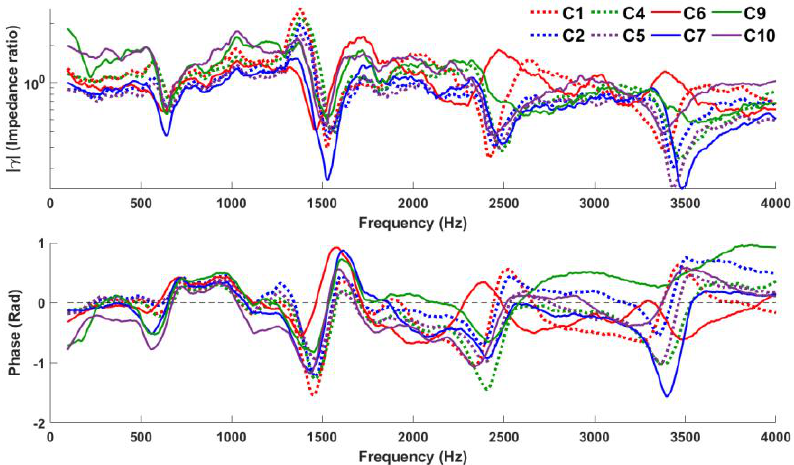
Figure 7. Comparison of eight configurations (C1 to C10, excluding C3 and C8).